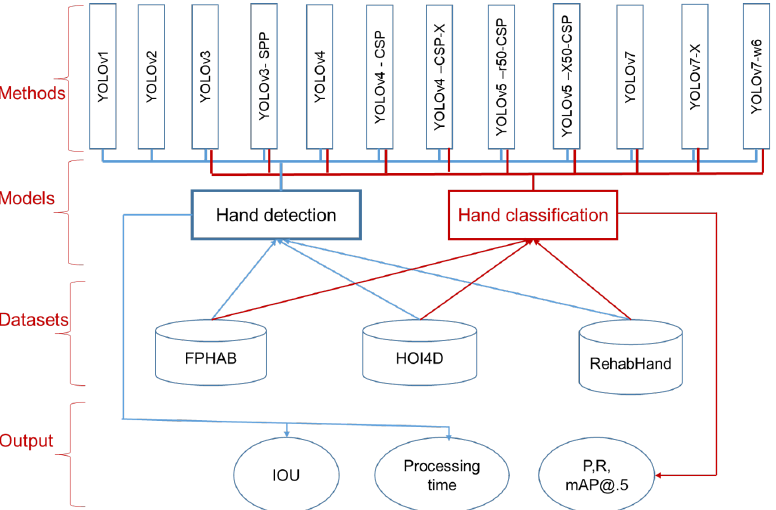
Figure 15. The taxonomy of the comparative study for hand detection and classification is based on the YOLO-family